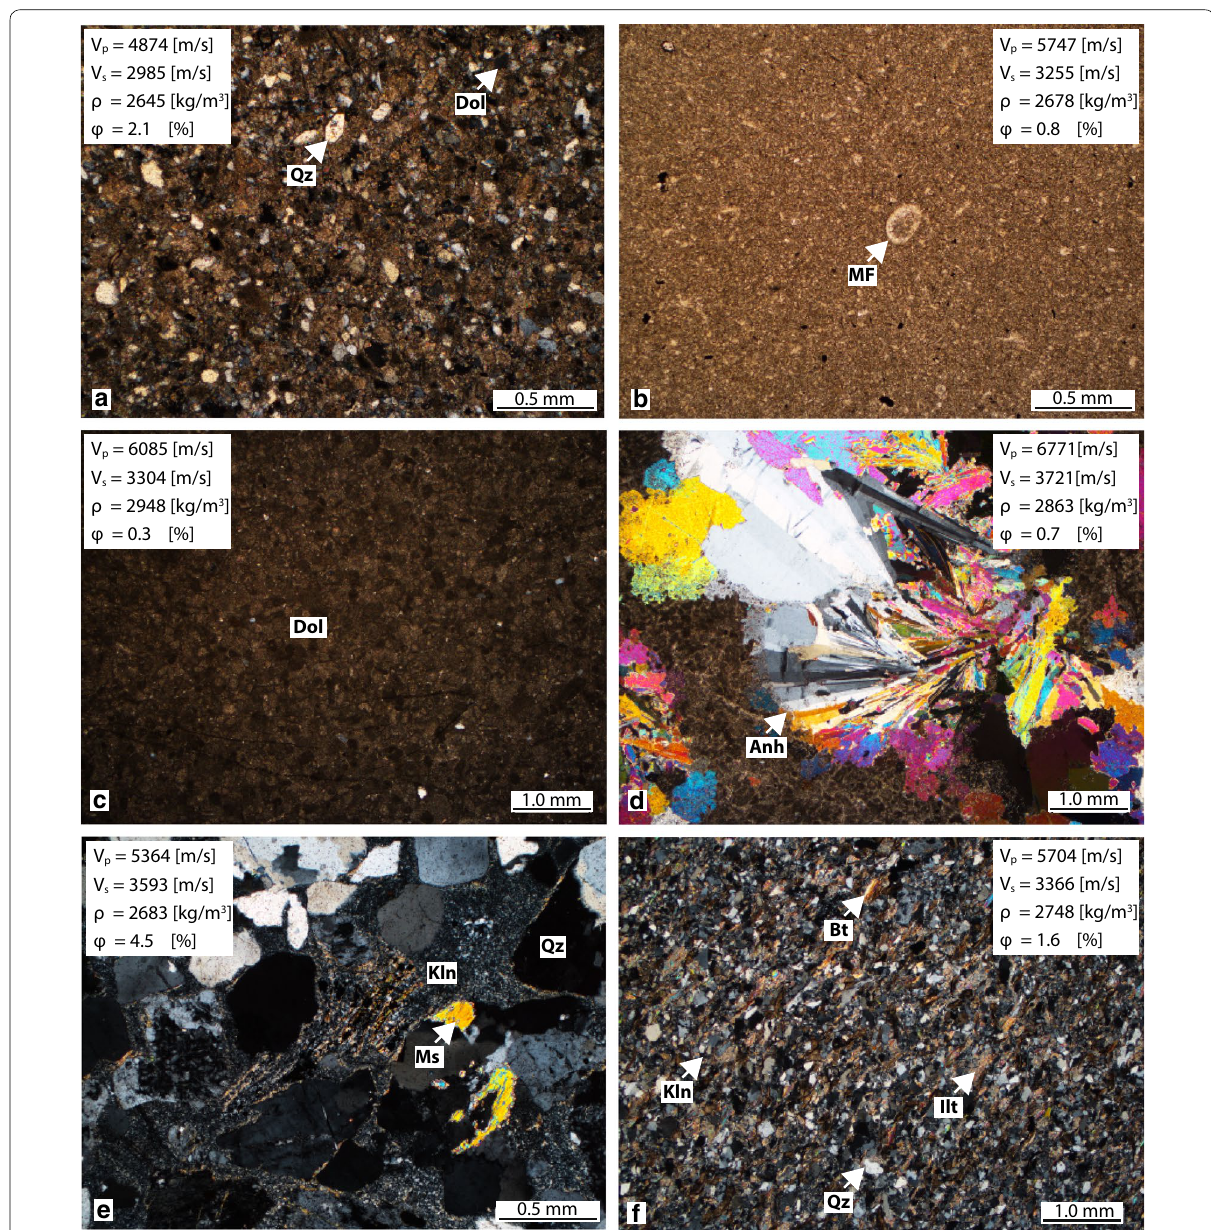
Fig. 6 Representative optical photomicrograph showing: a sample HU13; Pliensbachian—Posidonia shale. A considerable fine quartz (Qz) sand content exceeds 27% in volume are embedded in micrite ‘composed of 1–4 µ m-sized clay mineral’. Fine-crystalline dolomite (Dol) rhombs are embedded in the mud matrix; sample HU-13. b sample HU14; Sinnemurian—very fine-grained homogeneous micrite (> 91% calcite). A few of shell fragment (benthonic forams) which are preserved as a mold (MF) and filled with mostly diagenetic calcite, are embedded within very fine-grained homogeneous micrite. c sample HU21; Triassic Muschelkalk shows the microcrystalline micrite-dominated dolostone (fine-crystalline dolostone (Dol). d sample HU24; Triassic Muschelkalk presents the abundance of fibrous anhydrite (Anh) as the evaporite minerals in dolomitic (Dol) carbonate-support. e sample HU25; Triassic Buntsandstein. The kaolinization (Kln) of K-feldspar (Kfs) is occurring to form the clay cement for pore-filling and grain-coating on Quartz (Qz) minerals. Micro-fractures in quartz grains are not so common and filled by later diagenetic minerals. f sample HU29; Permo-Carboniferous unit. It shows slight laminations of fine-quartz (Qz) grains associated with kaolinite and biotite (Bt). The preservation of detrital feldspar and clay minerals (background) significantly contribute in the reduction of the porosity (0.87 ±